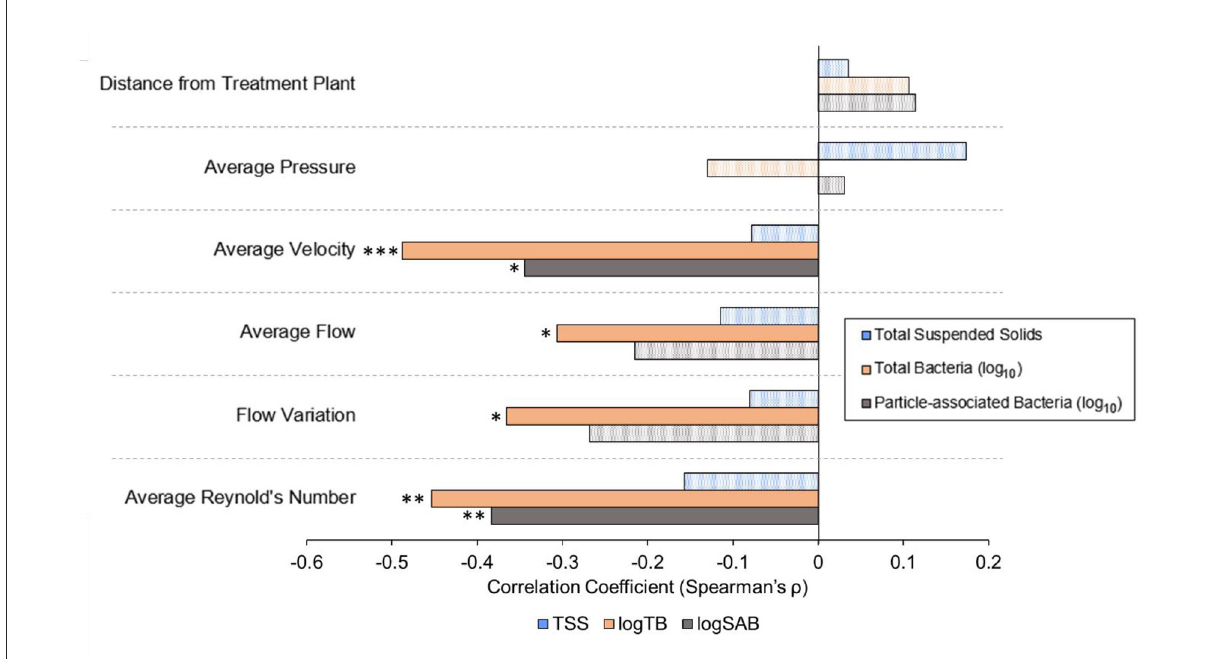
FIGURE6 Spearman’s rank sum correlation coefficients calculated between hydraulic or distribution system variables and key water quality data across all sampling dates. Solid bars represent statistically significant correlations ( α = 0.05). Patterned bars are not statistically significant. P -values are indicated as * < 0.05, ** < 0.01, and